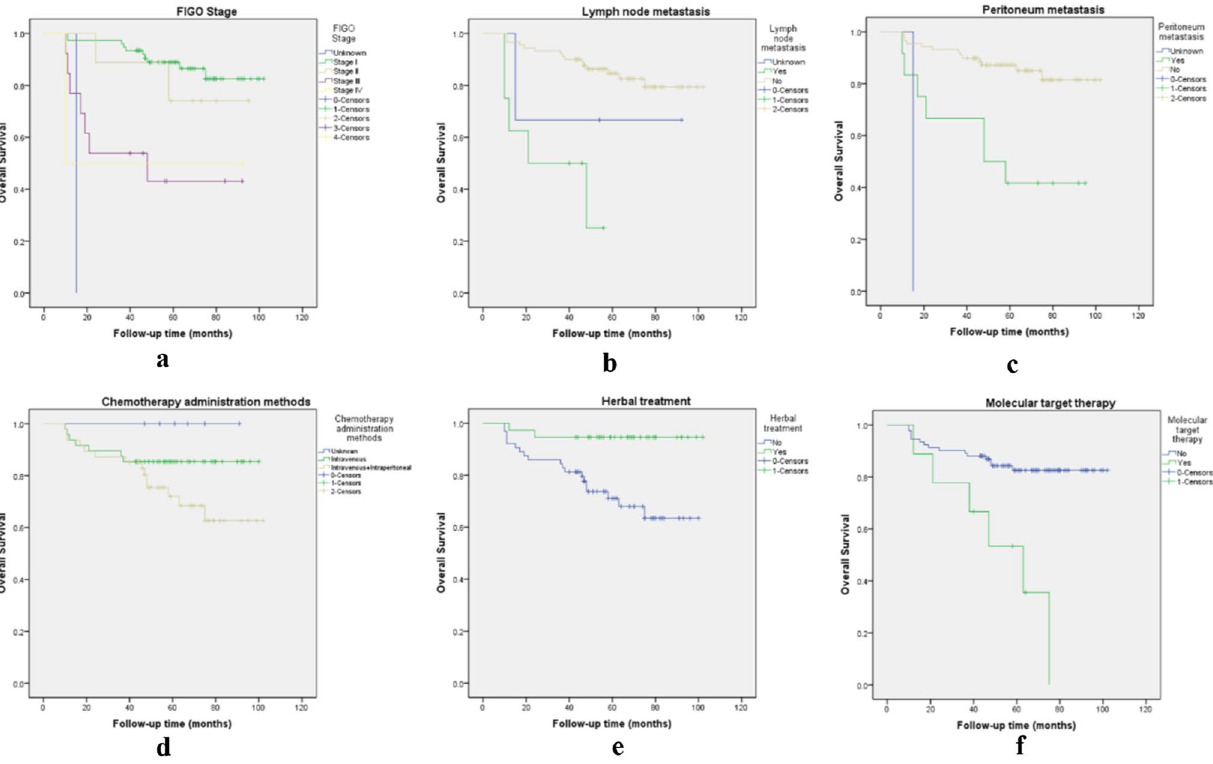
Fig. 2 ( a , b , c , d , e , f ). Survival curves of prognostic factors for overall survival by FIGO stage ( a ), lymph node metastasis ( b ), peritoneum metastasis ( c ), chemotherapy administration methods ( d ), Chinese herbal treatment ( e ), molecular target therapy ( f